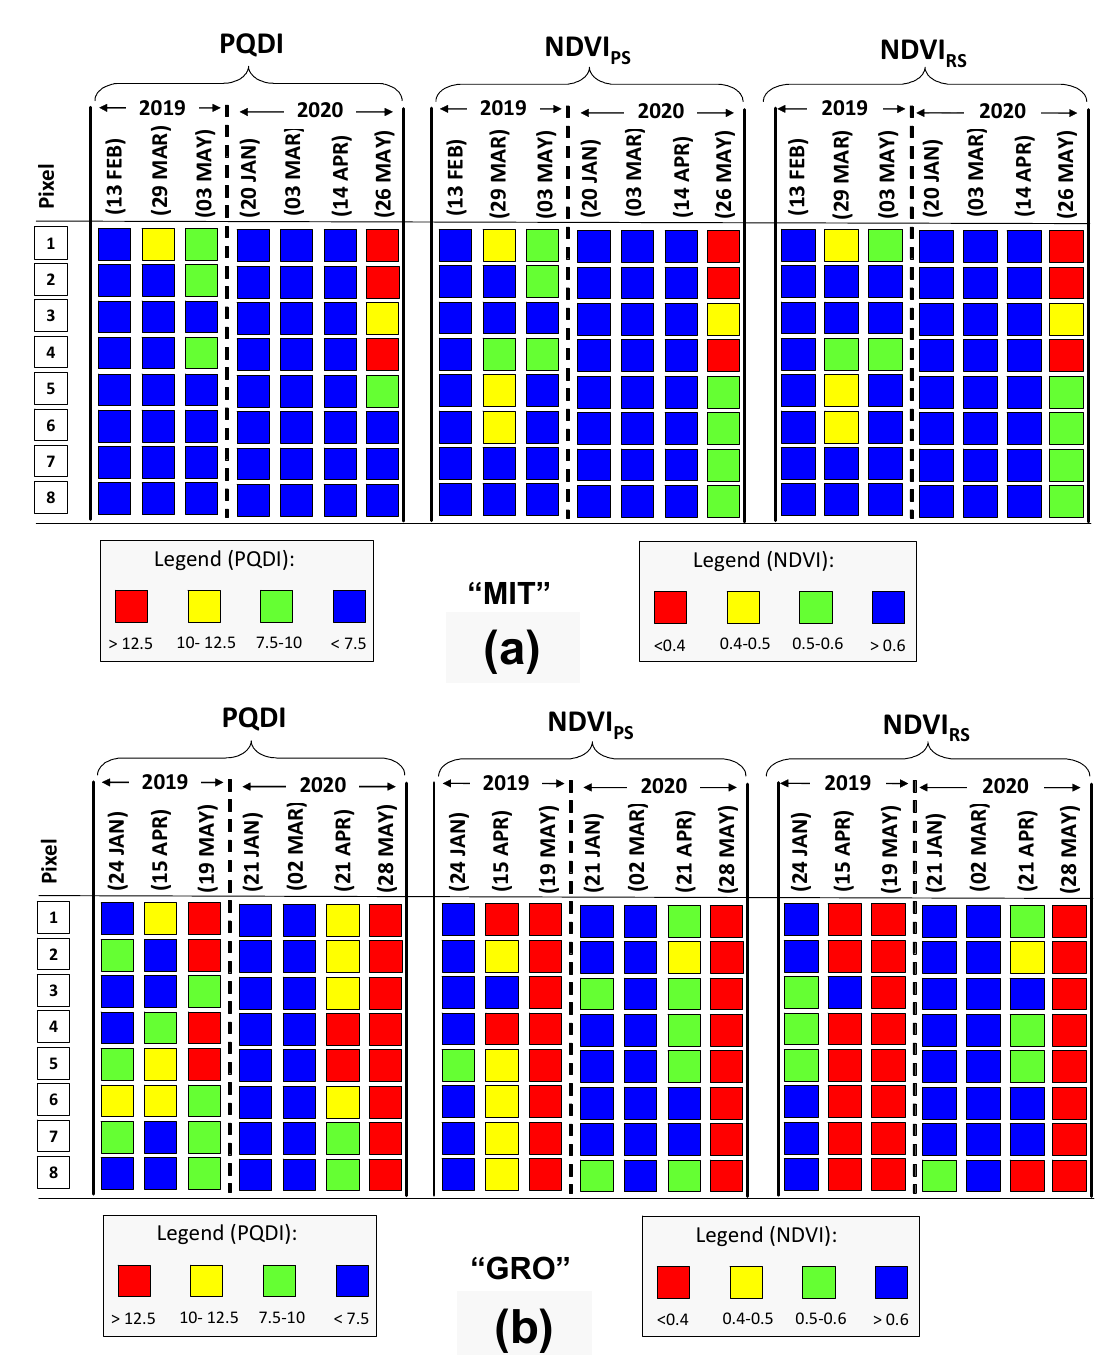
Figure 16. Evolution of pasture quality degradation index (PQDI) and normalized difference vegetation index (NDVI) obtained by proximal and remote sensing (PS and RS, respectively) over time, in “MIT” ( a ) and “GRO” ( b ) experimental fields.